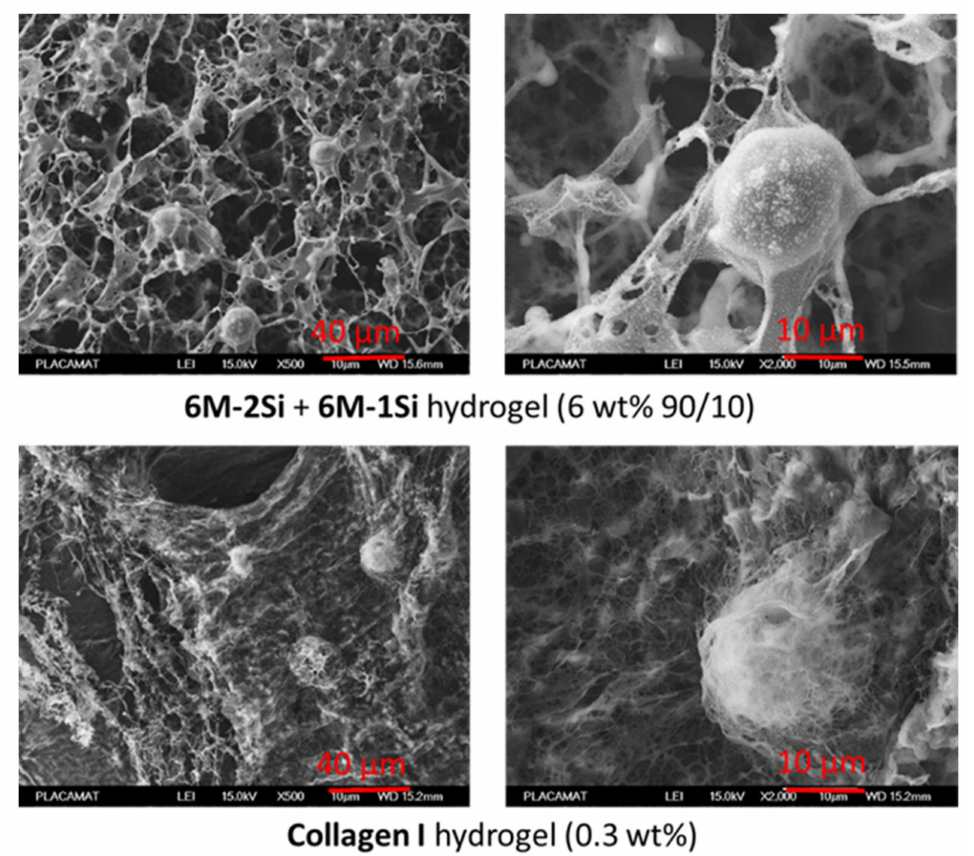
Figure 8. Cryo-SEM images of hydrogels made with 0.1 mg/mL NaF and 10 mg/mL glycine at 37 ◦ C in DPBS pH 7.4 with 10 6 hMSCs/mL one day after